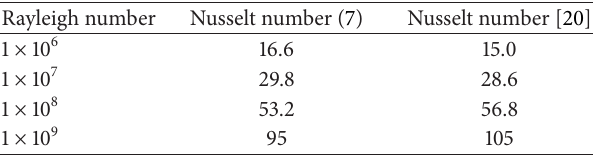
Table 2: Comparison of predicted Nusselt numbers with those reported by Chan and Tien [20]. Rayleigh